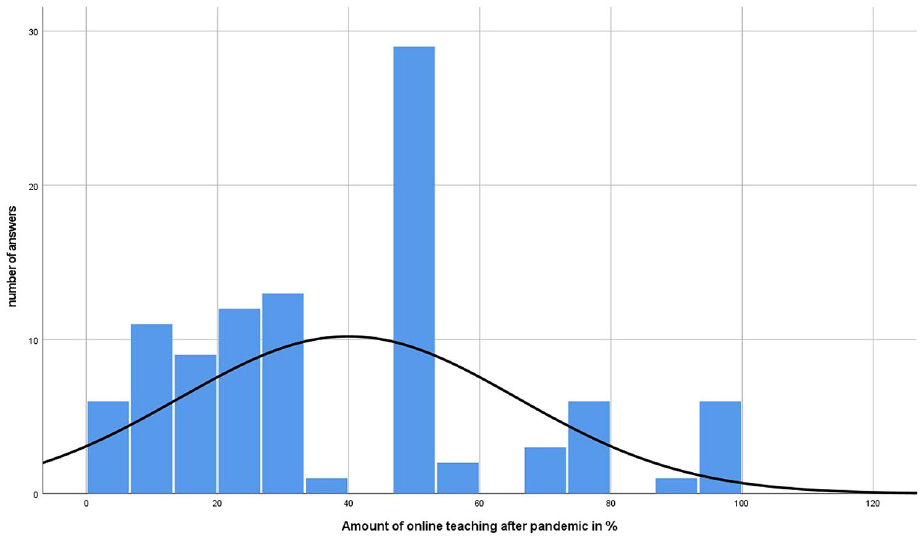
Figure 5. Results of online teaching desire of participants after pandemic in %.